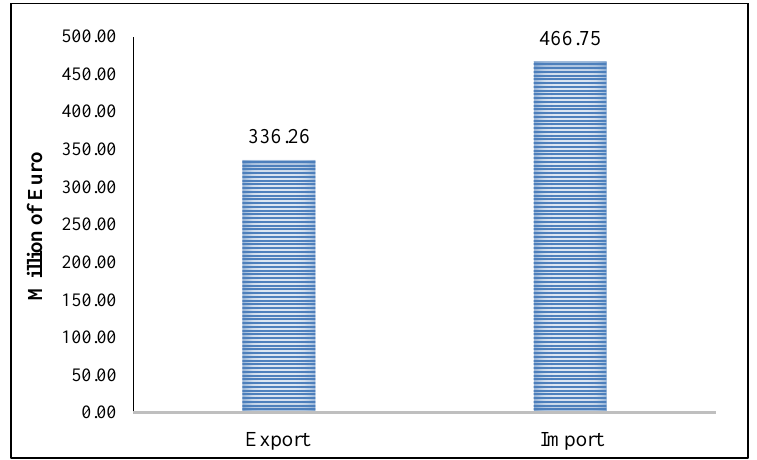
Figure 1. Comparison of import and export value in millions of Euros in Croatia in year 2018